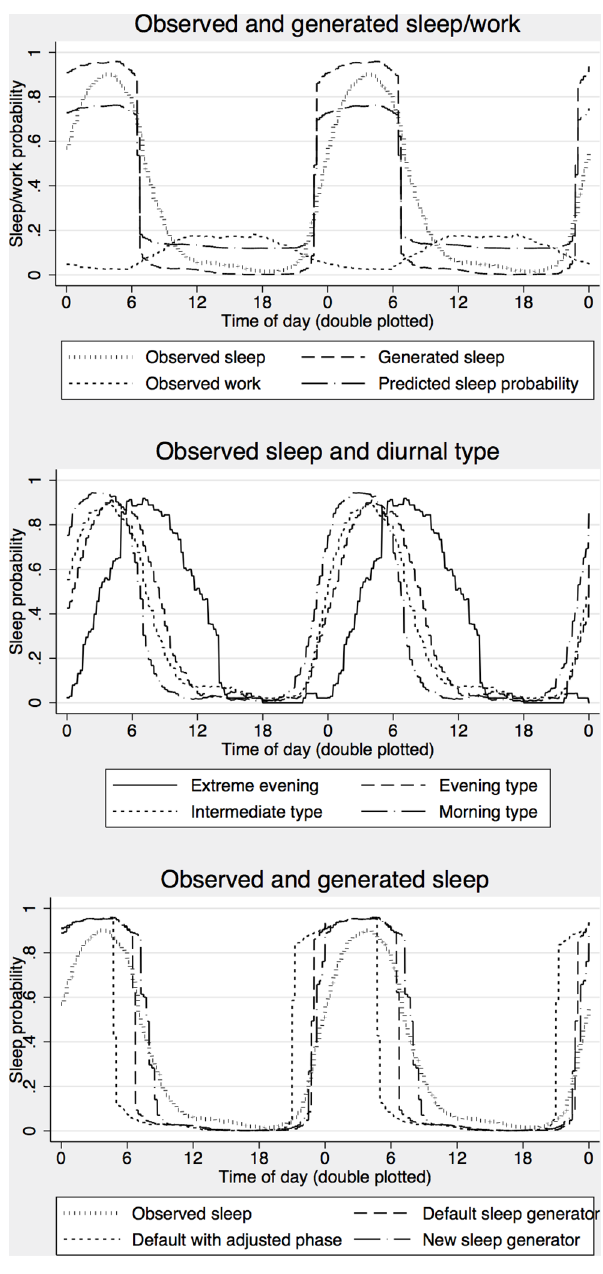
Figure 4. Observed, predicted and generated sleep. The top panel shows the proportion of observed 5 minute segments (n=577969 for 118 subjects with sleep data) with observed duty, observed sleep, sleep generated by the TPM (with default thresholds) and predicted sleep based on the fixed part of a multilevel mixed effects logistic regression (equation 15) with observed sleep as the dependent variable and generated sleep as the predictor. The middle panel shows observed sleep for different circadian types. The bottom panel shows the output from three different sleep generators. The default sleep generator used a fixed phase of C (p=16.8) for all subjects and threshold of S + C + U at 8.38 for falling asleep and 11.38 for waking up. Default sleep generator with adjusted phase use individually adjusted phases (p=14.61 h, 15.28 h, 15.95 h, 16.62 h) depending on rated circadian type (morning type – extreme evening type). The new sleep generator use adjusted phases of C T with a threshold for falling asleep of S + C , 8 and waking up S + C .